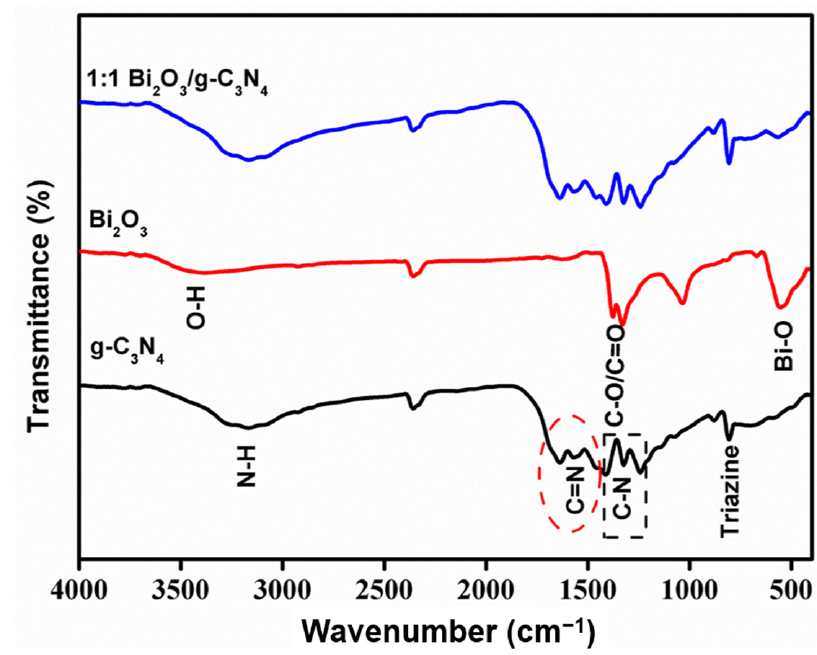
Figure 4. FTIR spectra of prepared samples.